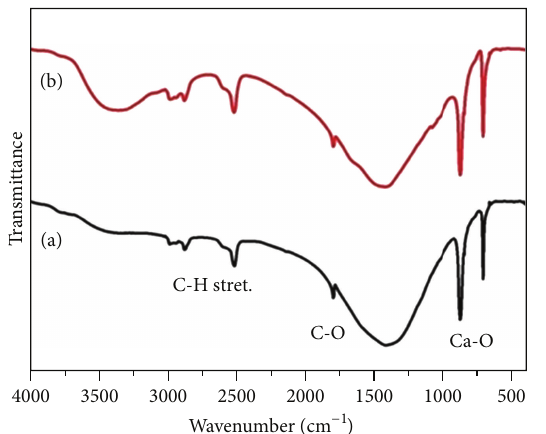
Figure 2: FTIR pattern of (a) eggshell and (b) commercial calcium carbonate.